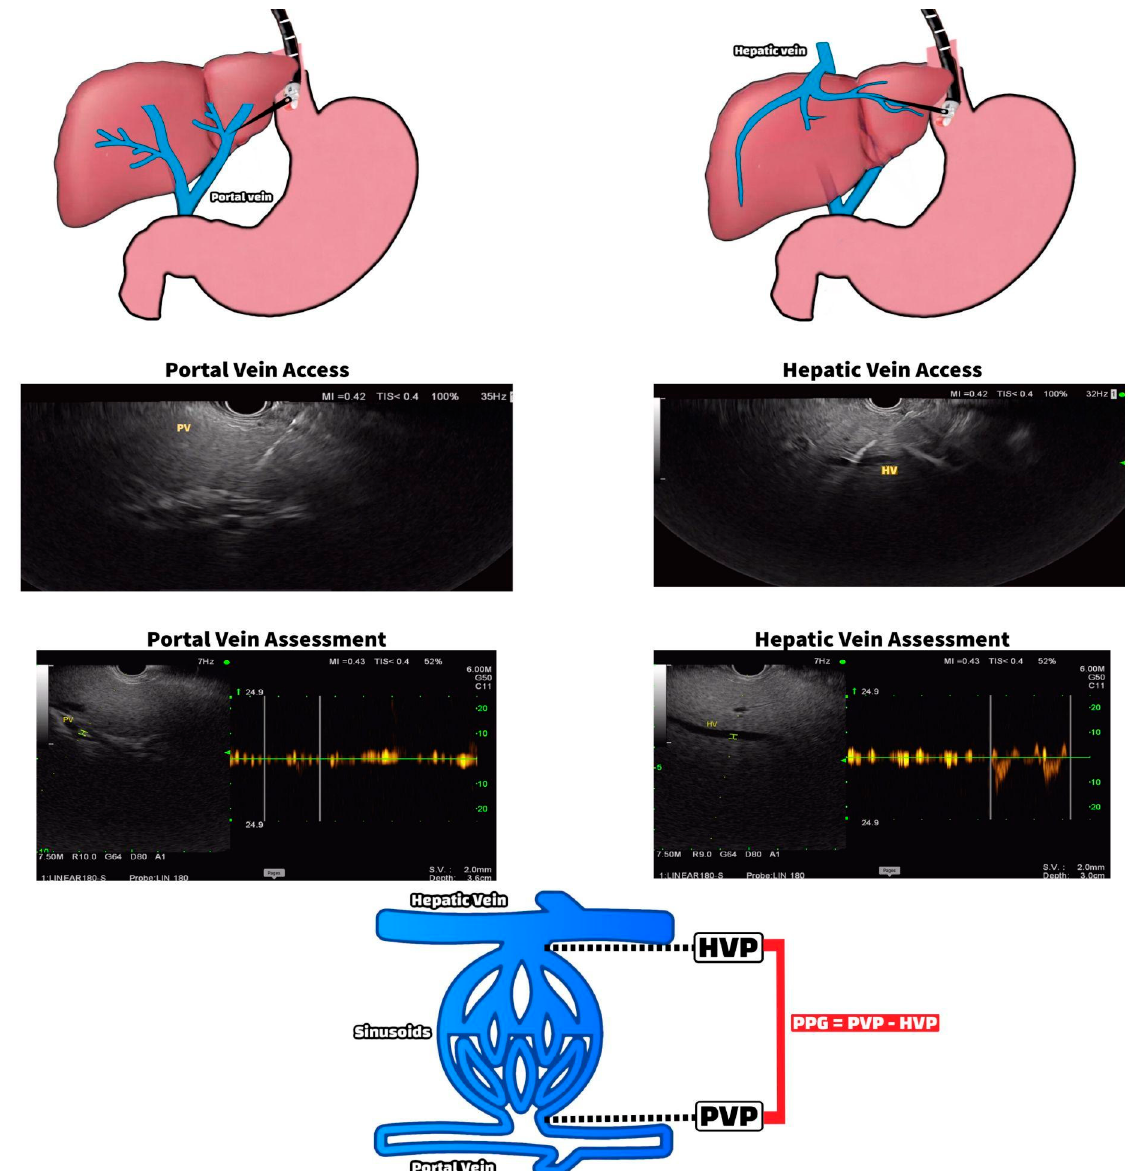
Figure 1. EUS-guided portal pressure gradient measurement.